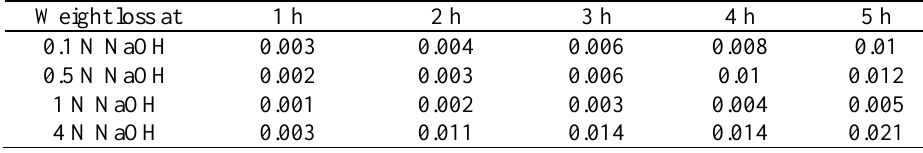
Table10. Weight loss of Cu in KOH